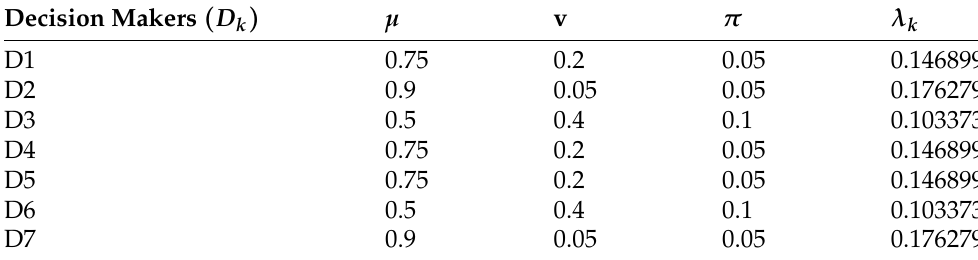
Table 5. Importance of decision